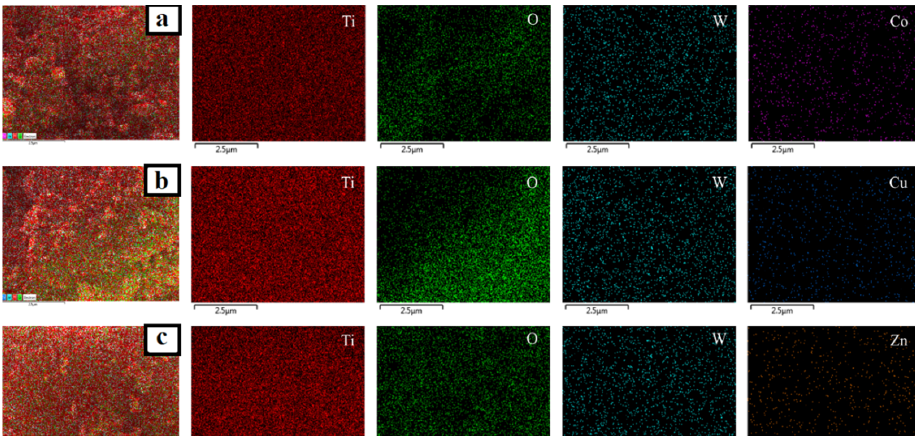
Figure 12. EDS mapping images of ( a ) W ‐ Cu ‐ TiO 2 , ( b ) W ‐ Co ‐ TiO 2 , and ( c ) W ‐ Zn ‐ TiO 2 .